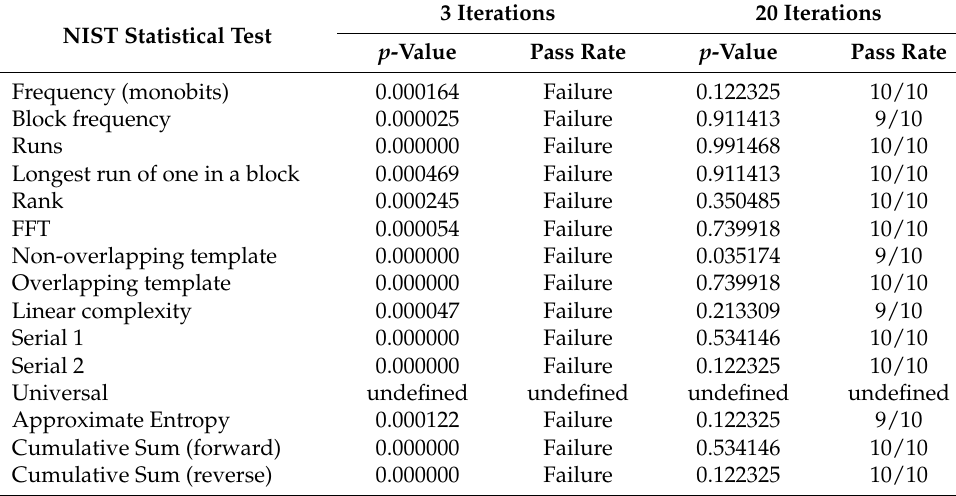
Table 5. Statistical testing of system with different number of iterations (NIST